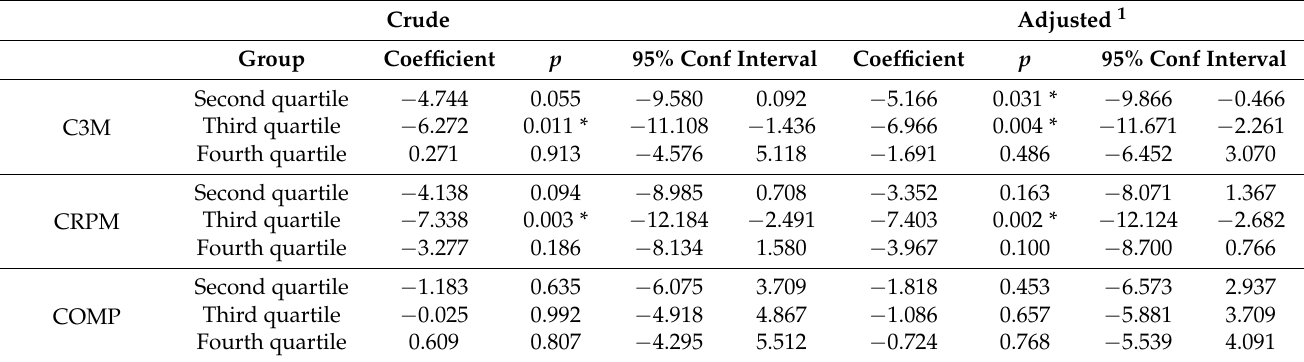
Table 5. Association between biochemical markers of matrix turnover and knee function. Crude Adjusted 1